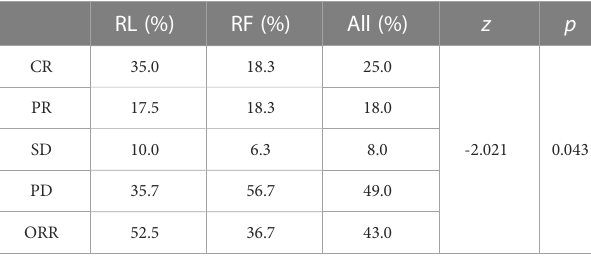
TABLE 3 Response of salvage therapy in R/R PCNSL.